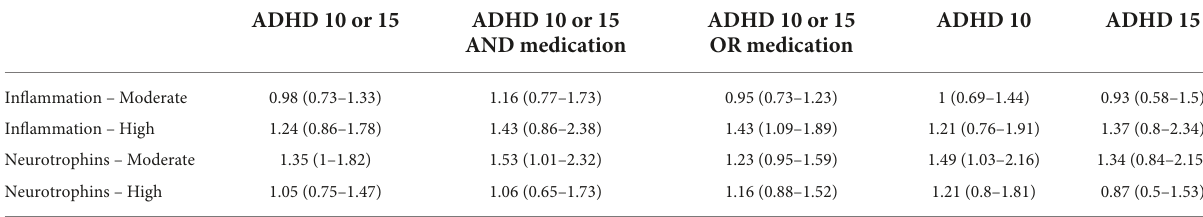
TABLE 5 Adjusted analyses for ADHD outcomes by inflammatory or neurotrophic protein